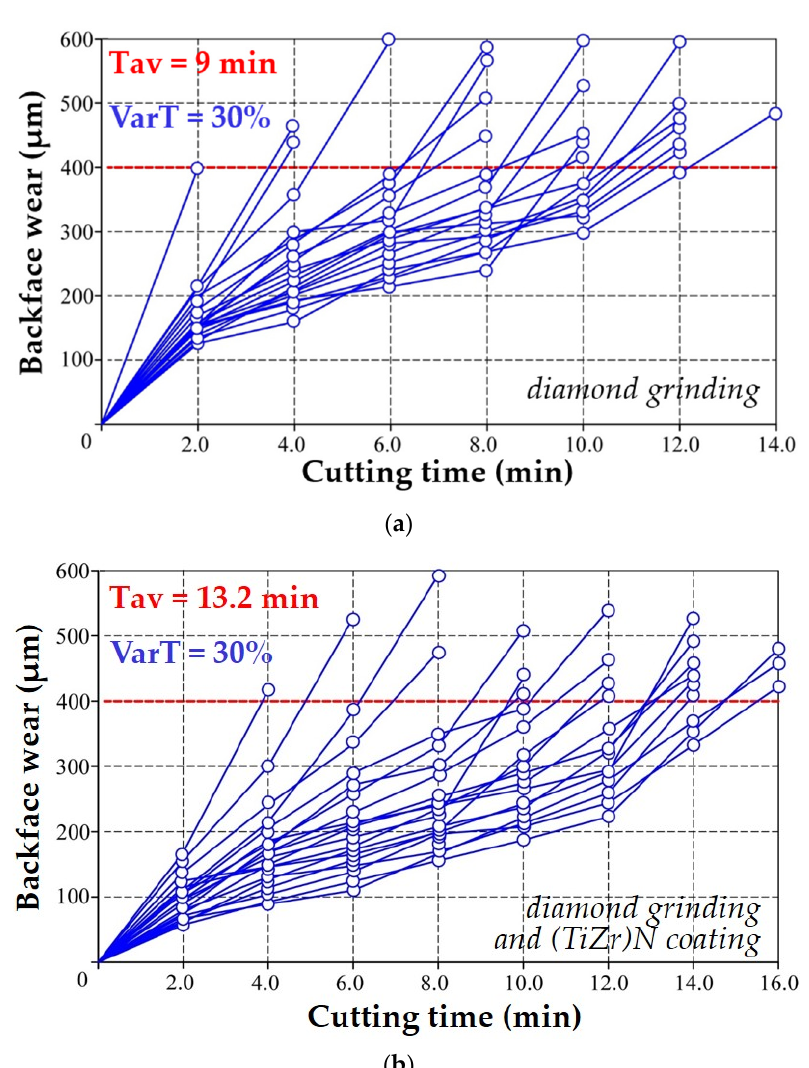
Figure 10. Group of “wear–cutting time” curves of cutting faces of ceramic inserts made of Al 2 O 3 +TiC after diamond grinding when milling hardened steel 100CrMn6 (V = 380 m/min, S = 0.15 mm/tooth, t = 1 mm) uncoated ( a ) and coated with (TiZr)N ( b ).